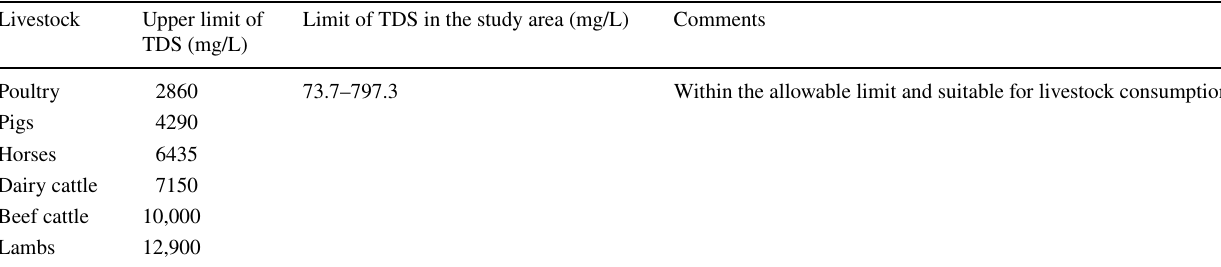
Table 5 Upper limit of TDS for livestock consumption Livestock Upper limit of Limit of TDS in the study area TDS (mg/L)